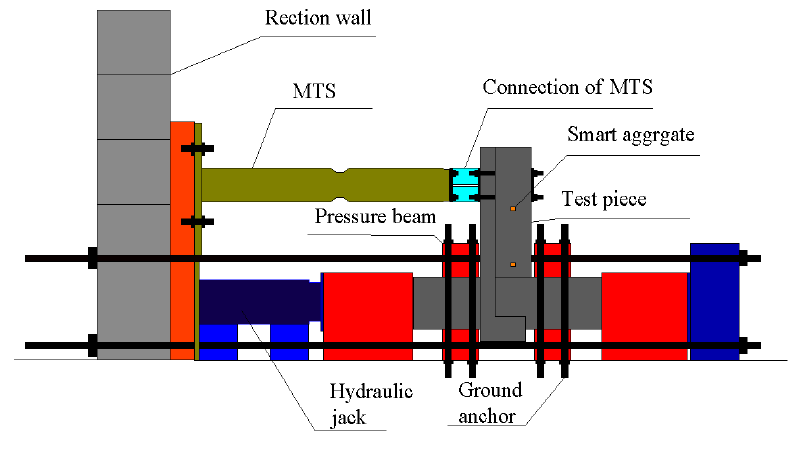
Figure 16. Loading device.